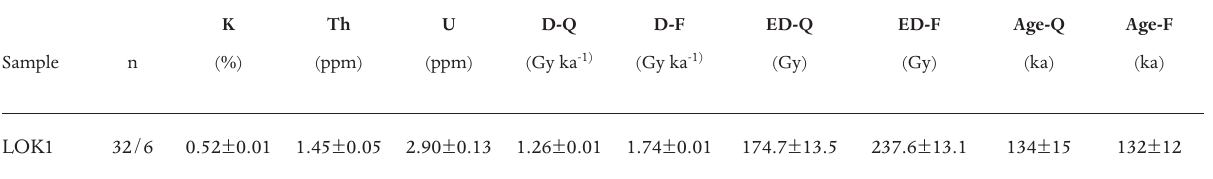
Table 1. Summary data of OSL and IRSL dating giving the number of replicate measurements (n), the concentration of dose rate relevant elements (K, Th, U), dose rate (D), equivalent dose (ED), and resulting ages for both quartz (Q) and feldspar